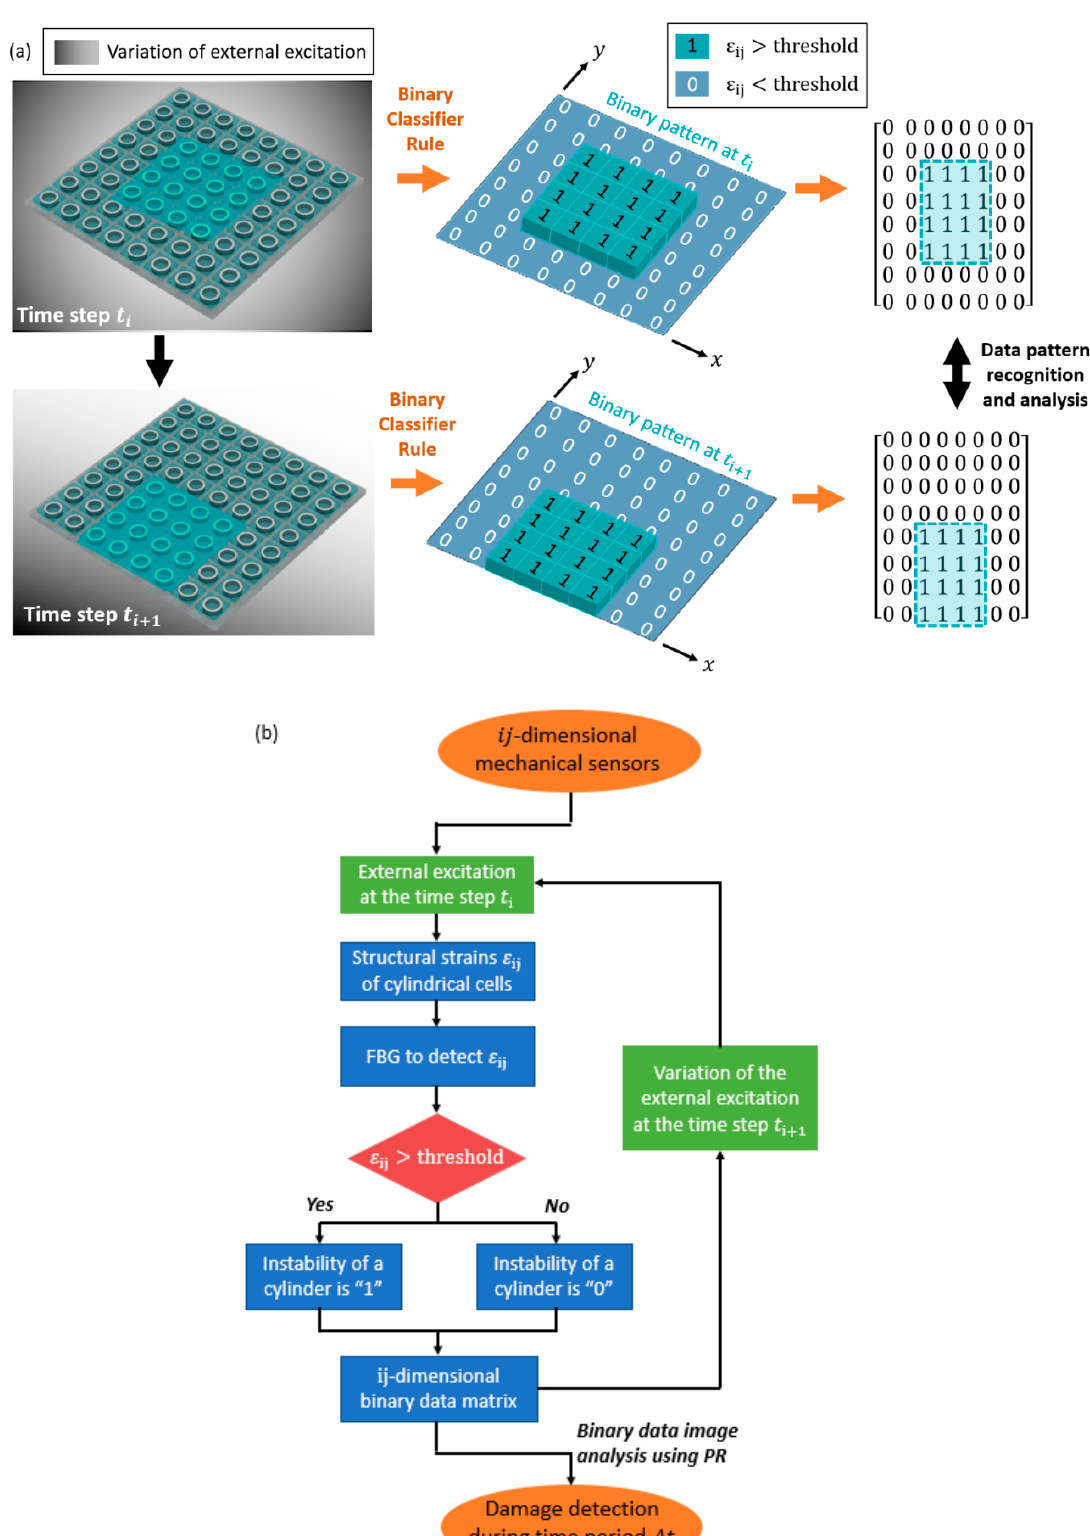
Figure 3. Pattern recognition scheme for the FBG-enabled binary data from the mechanical sensors. ( a ) Schematic illustration of the pattern scheme that analyzes the binary data detected from the FBG. ( b ) A flowchart that indicates the procedures of the binary classifier rules and data analysis.